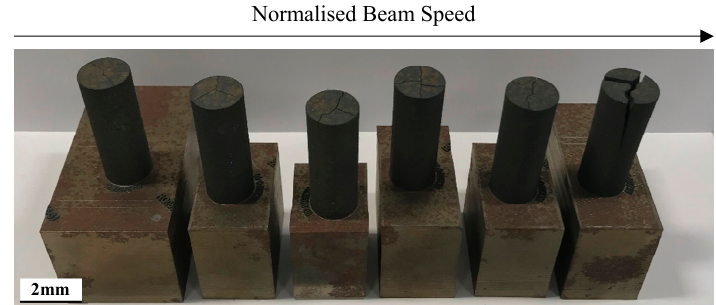
Figure 7. Influence of normalised beam speed on the severity of macrocracking in AB material.